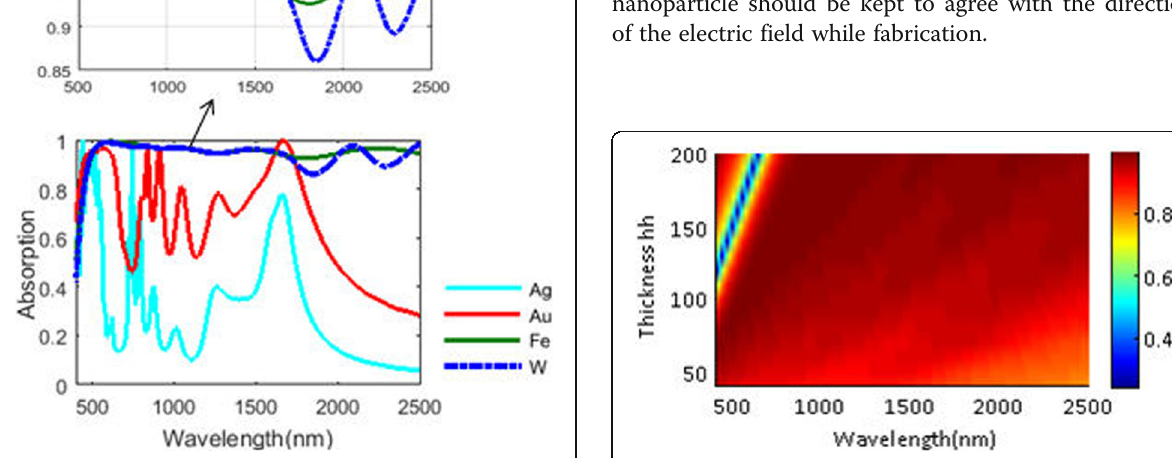
Fig. 11 Absorbance of the eight-layer NPA structures with different metals applied